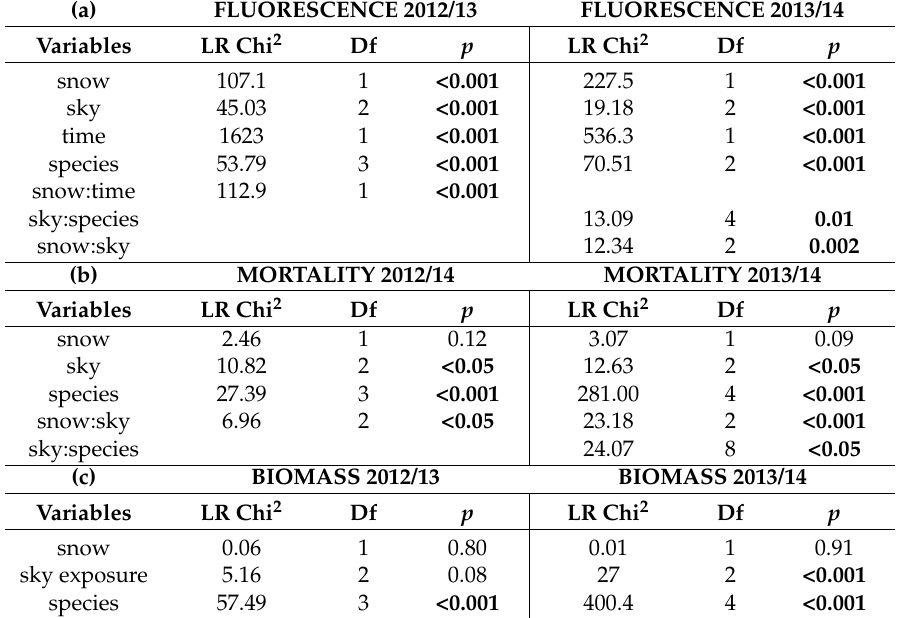
Table 2. Model estimates and Tukey-adjusted pair-wise comparisons (snow:sky exposure), averaged over three species and two measurement time, in a GLM model assessing the effect of snowmelt timing and sky-exposure treatments on fluorescence parameter Fv/Fm in tree seedlings at the alpine treeline, spring 2014. Snow treatments: early and late snowmelt; sky-exposure treatments: control (no roof), shade (shade roof during the day), and nightwar = night warming (shade roof during the night). Asymp. SE = Standard error, Asymp.LCL and Asymp.UCL = asymptotic lower and upper control limits. Groups indicate significantly different treatment